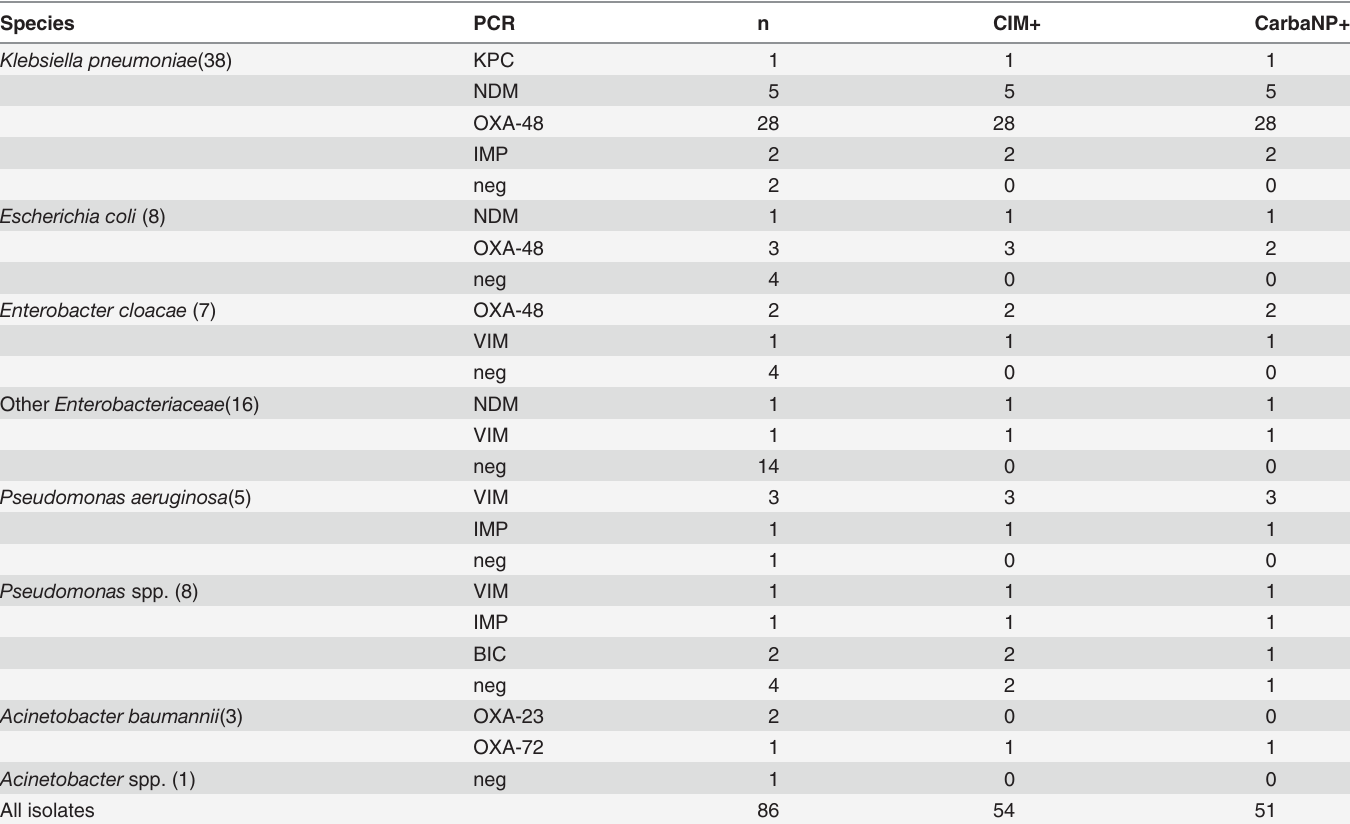
Table 5. Comparison of the CIM and Carba NP